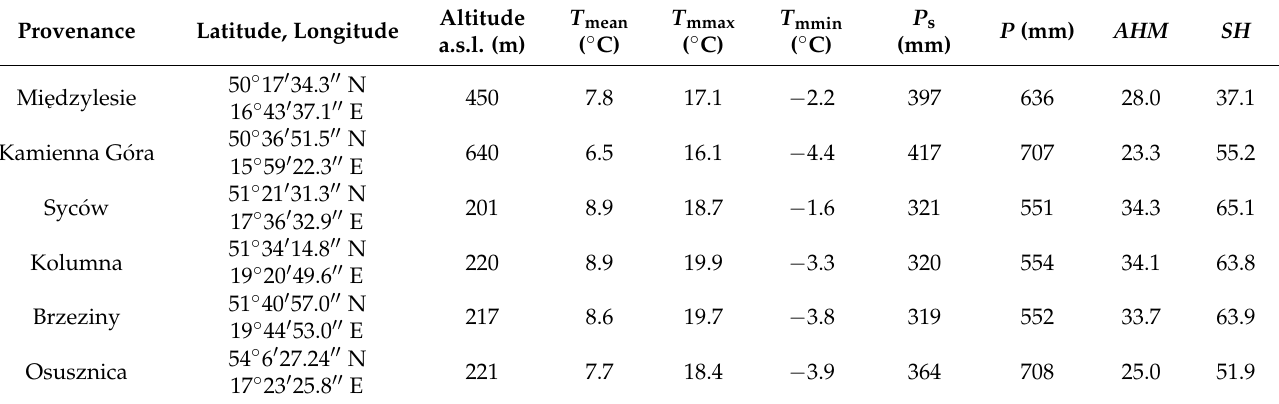
Table 1. Climate characteristics of seed stands where Abies alba cones were collected.